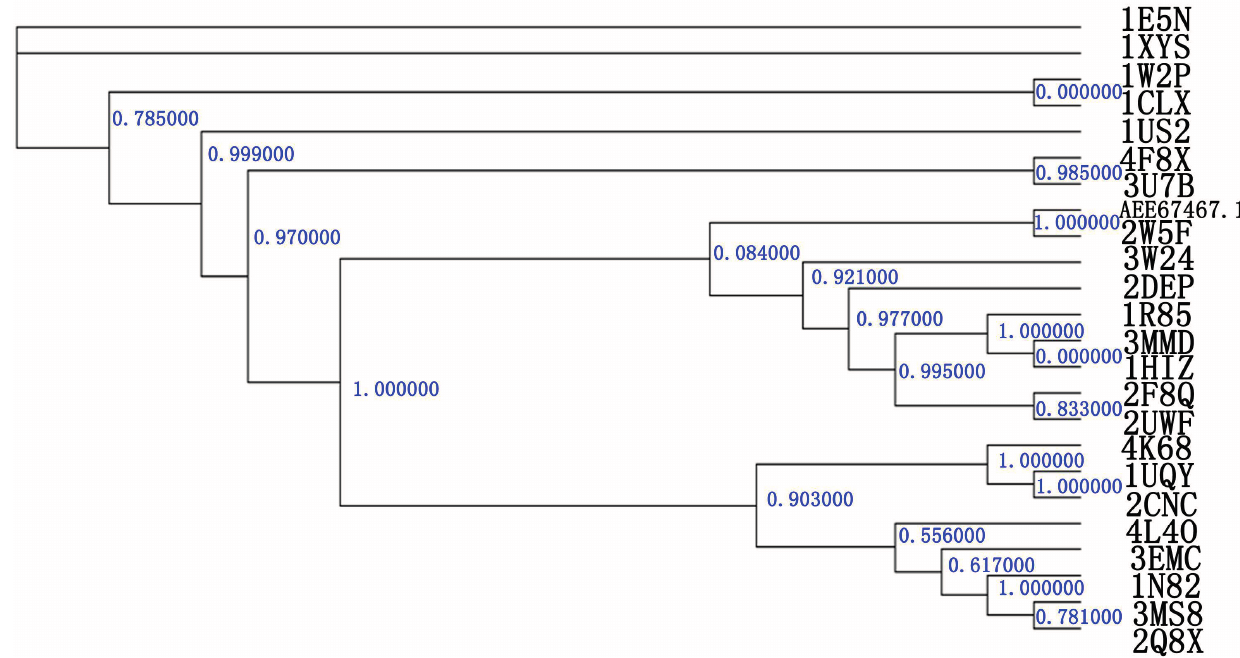
Figure 1. A phylogenetic tree of GH10 family. R. albus 8 (Xyn10A) (No. AEE64767.1).